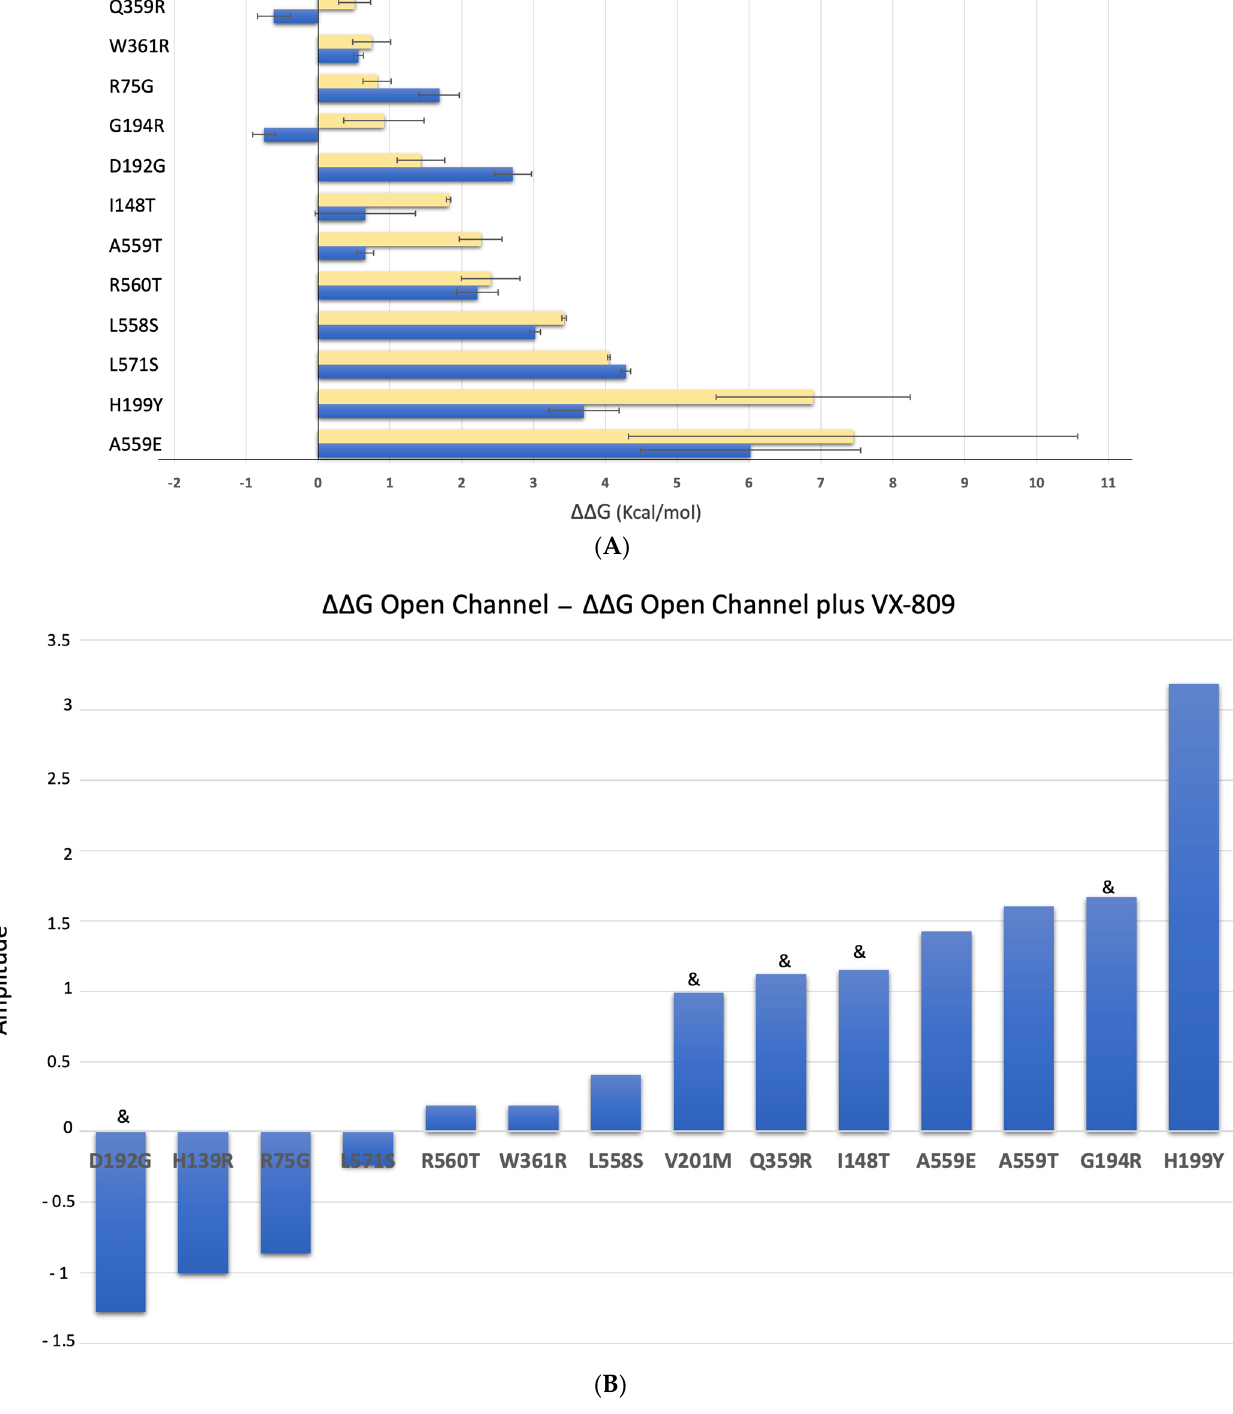
Figure 7. Energy prediction of ∆∆ G (kcal/mol) of CFTR mutants in the presence and absence of VX-809 calculated with FoldX [29]. ( A )—yellow bars: human CFTR bound to phosphorylated ATP (6msm)—“open” conformation [28], (similar to Figure 6A); blue bars: human CFTR + Mg/ATP + VX-809 (pdb:7svd) [22]; bars are presented as mean ± standard deviation. ( B )—Variation of ∆∆ G (kcal/mol) for CFTR variants calculated as the difference between the ∆∆ G “open” and the ∆∆ G “open” in the presence of VX-809. “&” corresponds to variants in which band C is present. mutants I148T, D192G, G194R, V201M and Q359R. Calculating the average of the